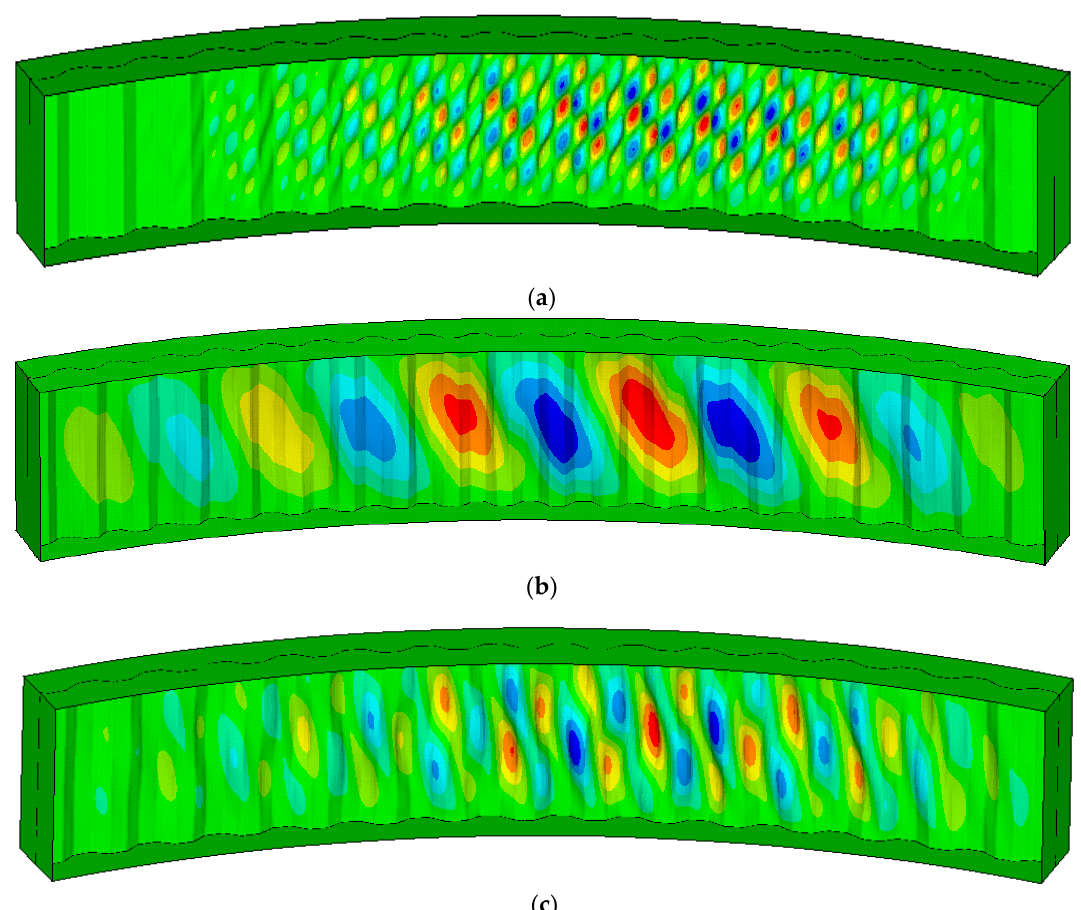
Figure 6. Three shear buckling modes: ( a ) Local shear buckling; ( b ) Global shear buckling; ( c ) Interactive shear buckling.